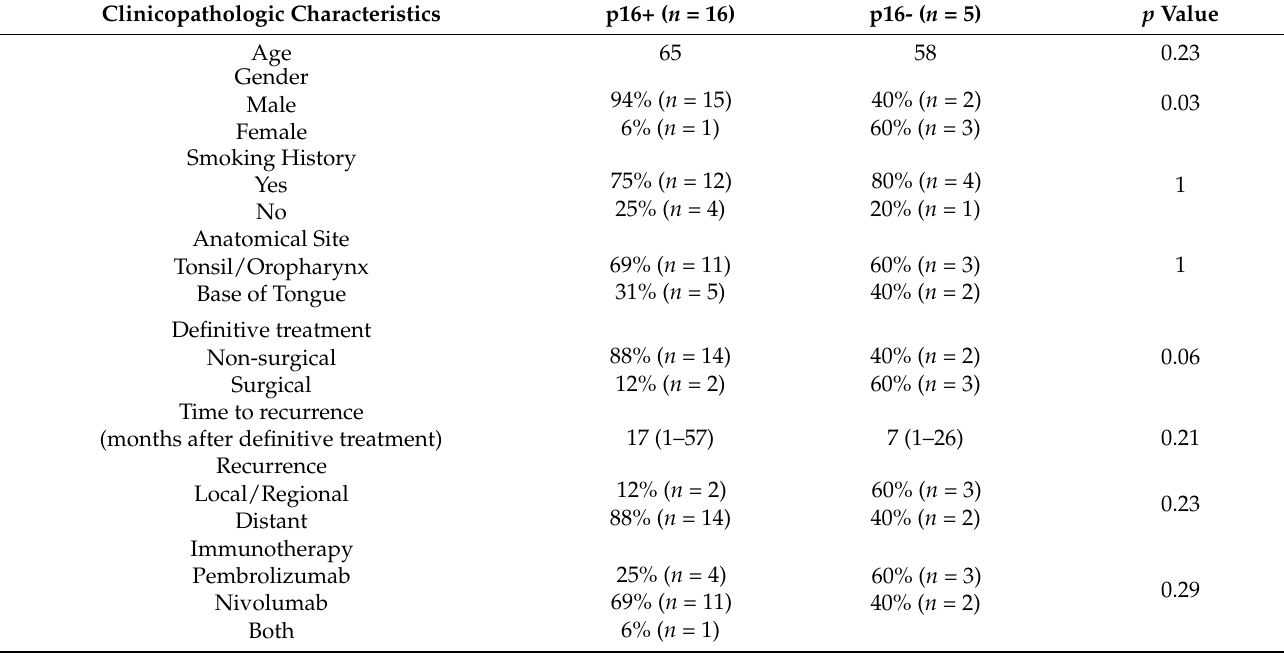
Table 2. Clinicopathologic characteristics of R/M OPSCC patients treated with anti-PD-1 immunotherapy. Clinicopathologic